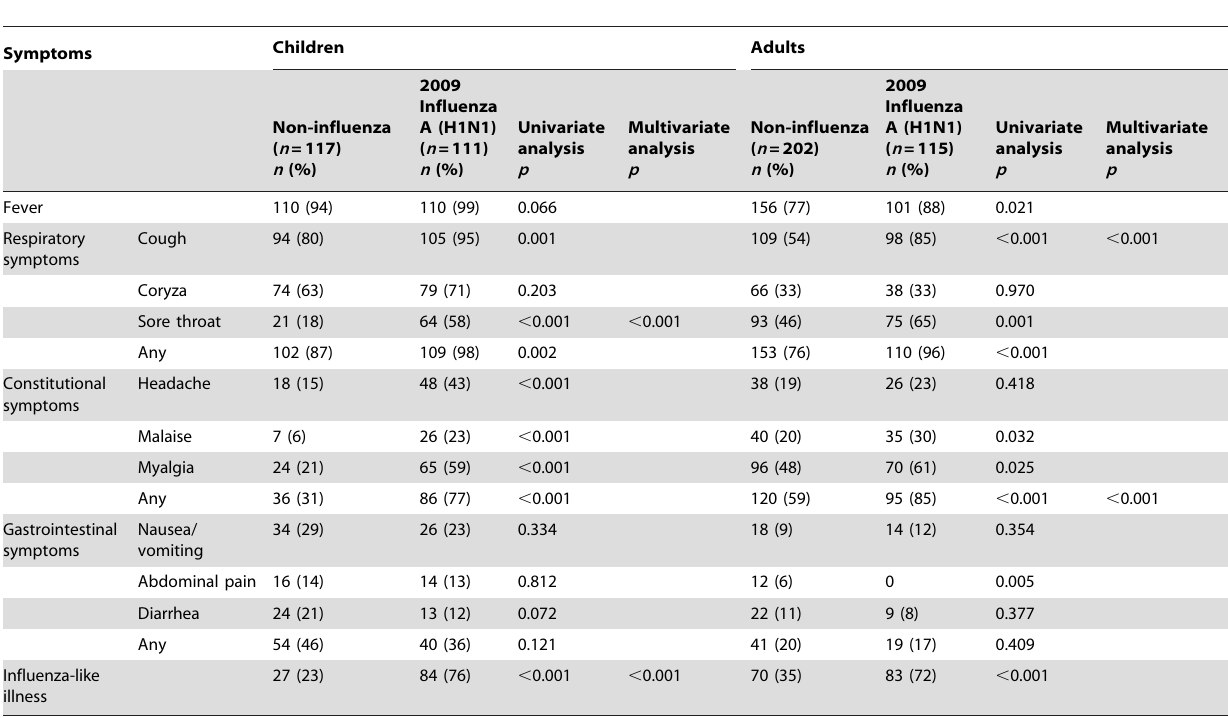
Table 2. Presenting symptoms in patients with non-influenza illness and 2009 influenza A virus (H1N1)